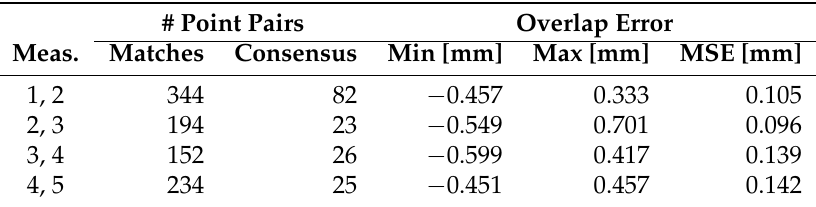
Table 2. Registration results for the overlapping regions of the considered 9 measurements: Number of total point pairs resulting from block matching, remaining consesus point pairs, and point-to-plane error within the overlapping area. # Point Pairs Overlap Error Meas. Matches Consensus Min [mm] Max [mm] MSE